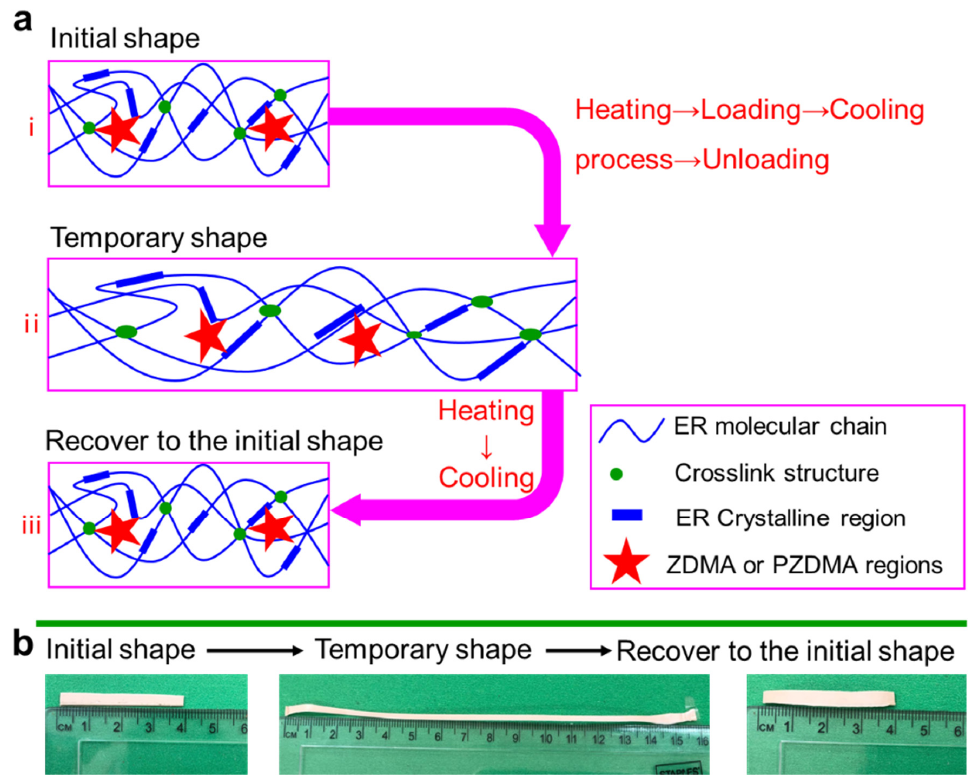
Figure 9. ( a ) Schematic diagram of the shape memory process of ER composites, and ( b ) physical diagram of shape memory process.